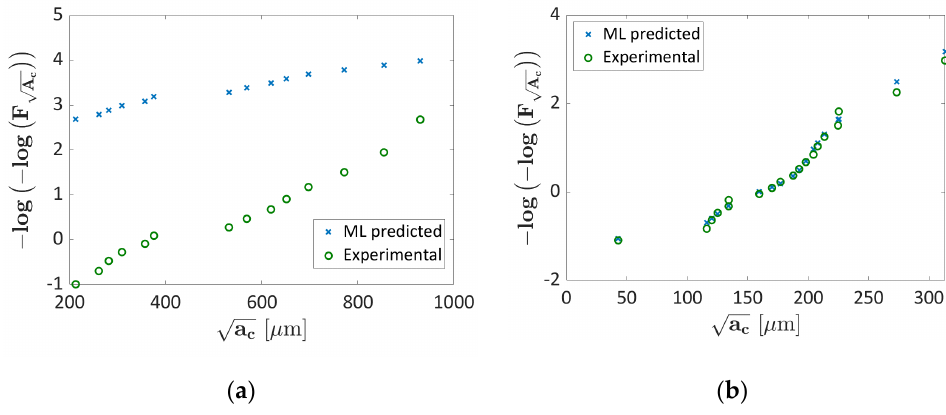
Figure 7. Gumbel plot for k = 1; ( a ) validation dataset; ( b ) training data.